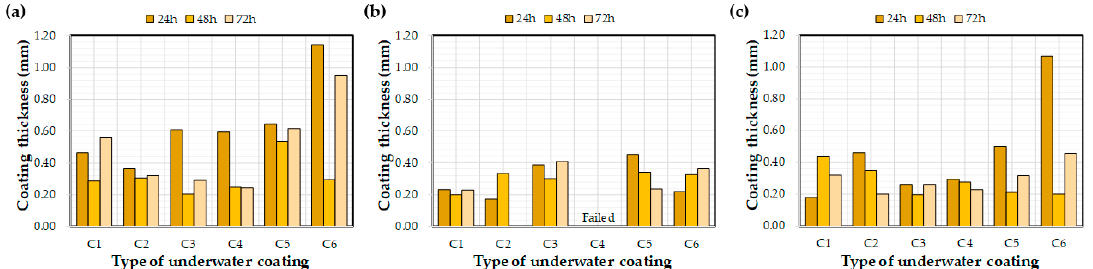
Figure 9. Effect of the water exposure time on the measured coating thickness: ( a ) control, ( b ) E1, and ( c ) E2.